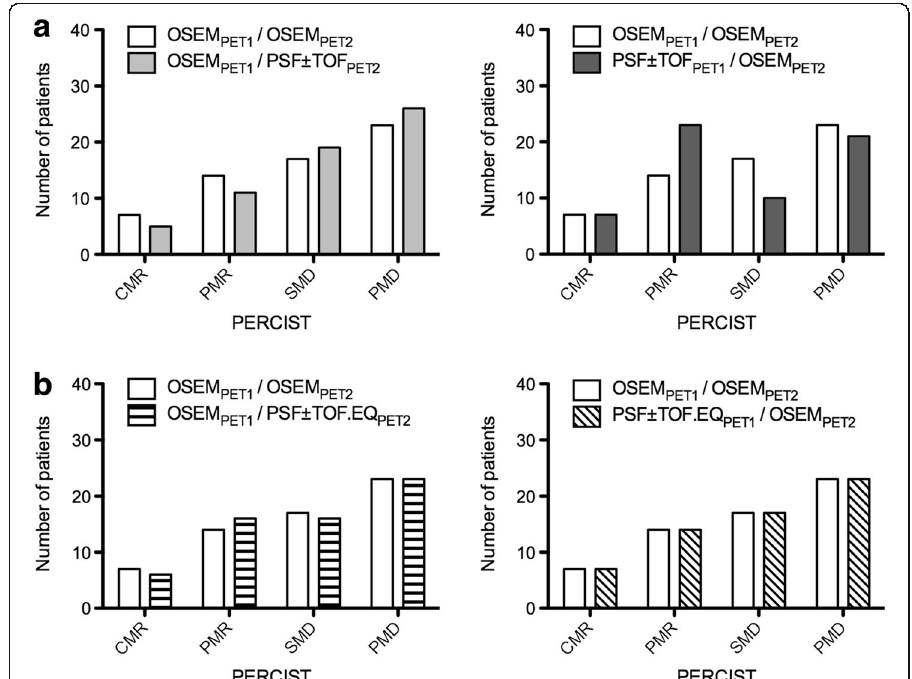
Fig. 4 Impact of reconstruction inconsistency on PERCIST classification. PERCIST classification is shown for the standard of reference (OSEM PET1 /OSEM PET2 ) and for other scenarios: reconstruction inconsistency between the baseline and post-treatment scans ( a ) and use of the EQ.PET methodology either for baseline or post-treatment scan ( b )